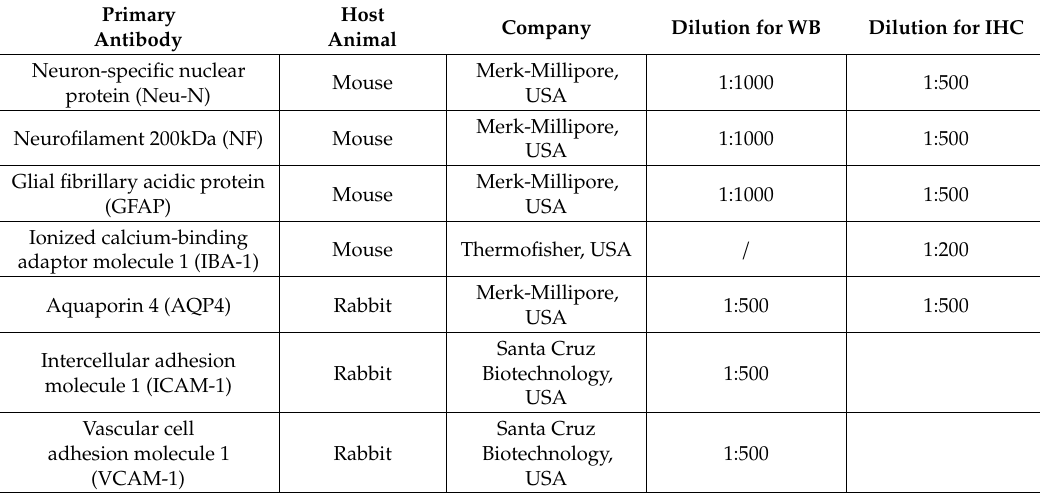
Table 1. The primary antibodies used for Western blot (WB) and immunohistochemistry (IHC)